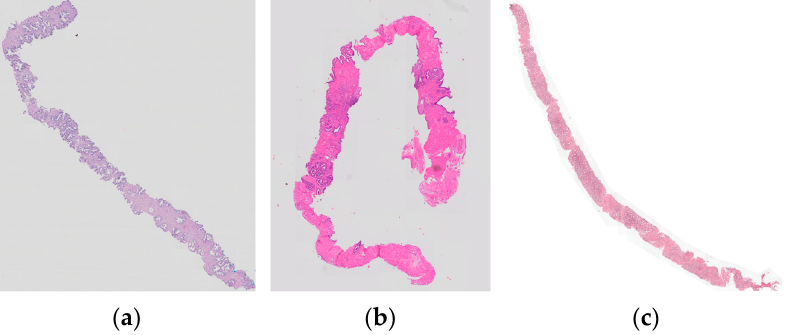
Figure 5. Examples to illustrate stain contrast differences among the samples in cohort: ( a , b ) UM/MCC dataset, ( c ) PANDA Radboud.